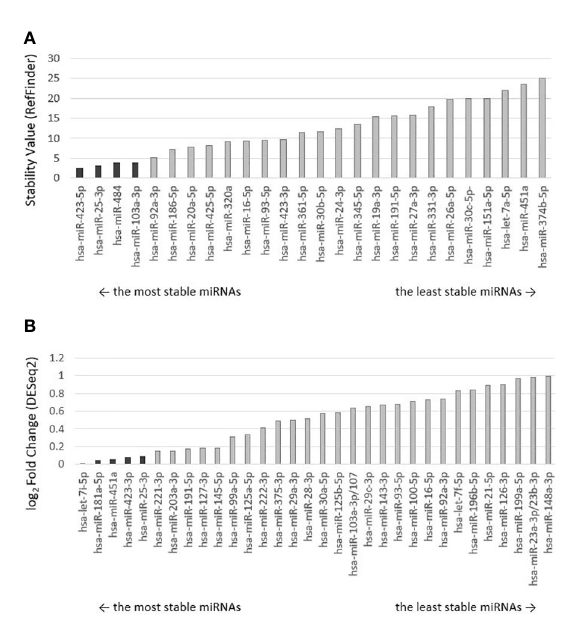
FIGURE 2 Ranking of miRNA controls by stability. Selected endogenous miRNAs are darkly highlighted. (A) The order of endogenous control miRNAs preselected on the micro fl uidic card by the manufacturer was determined by the RefFinder algorithm, which calculated and assigned a stability value to each miRNA. The lower the stability value, the more stably expressed miRNA and the more suitable it is for use as an endogenous control. (B) Ranking of selected endogenous miRNAs from small-RNA sequencing analysis evaluated by DESeq2 algorithm, which performed differential expression analysis. Low-expression miRNAs were excluded from the analysis. miRNAs are ranked from the lowest log2 Fold Change value (the lesser the value, the greater the stability between malignant and non-malignant samples).